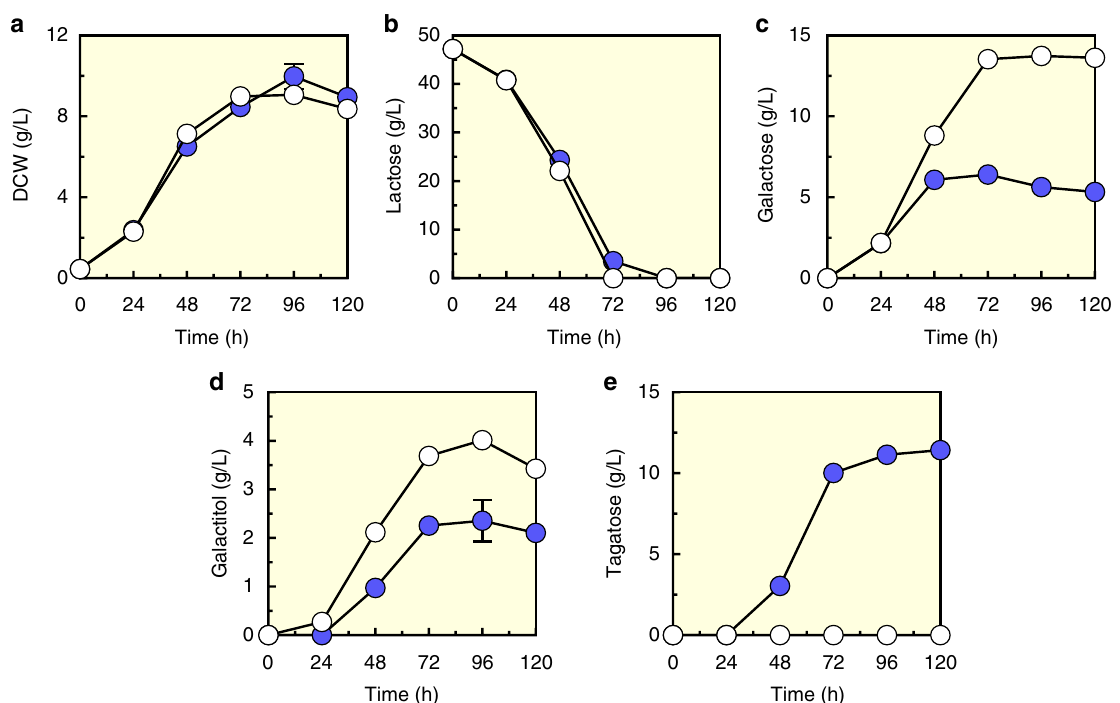
Fig. 3 Tagatose production after the introduction of galactitol-2-dehydrogenase (GDH). a Growth curve as shown by DCW, b lactose consumption, c galactose production, and d galactitol production, and e tagatose production by the EJ2g_pXpG strain ( fi lled circles) and the EJ2g_pX strain with p42H empty plasmid as control (open circles) under aerobic condition. Data are presented as mean value and standard deviations of three independent biological replicates. Source data are provided as a Source Data fi le